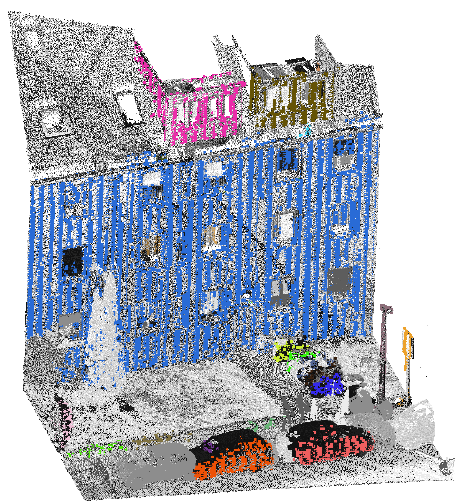
Figure 6. Result of the region growing algorithm. Each connected object is assigned a random